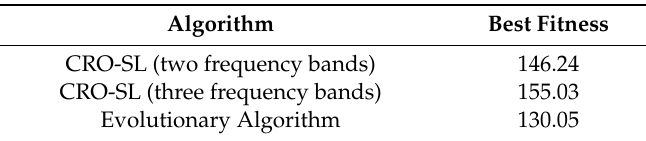
Table 3. Comparison of the best results obtained by the proposed CRO-SL approaches and an evolutionary algorithm.